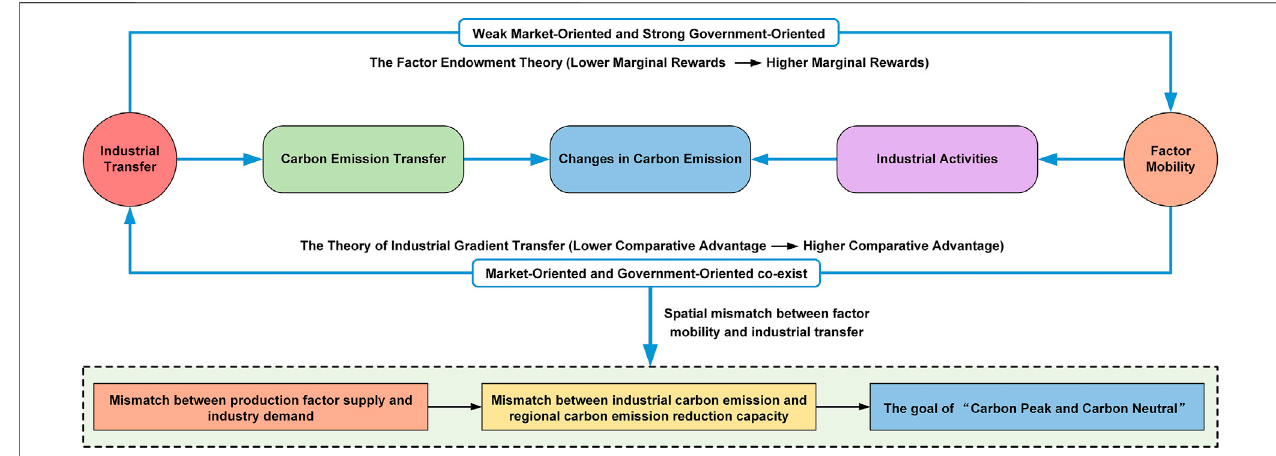
FIGURE 1 | Theoretical analysis